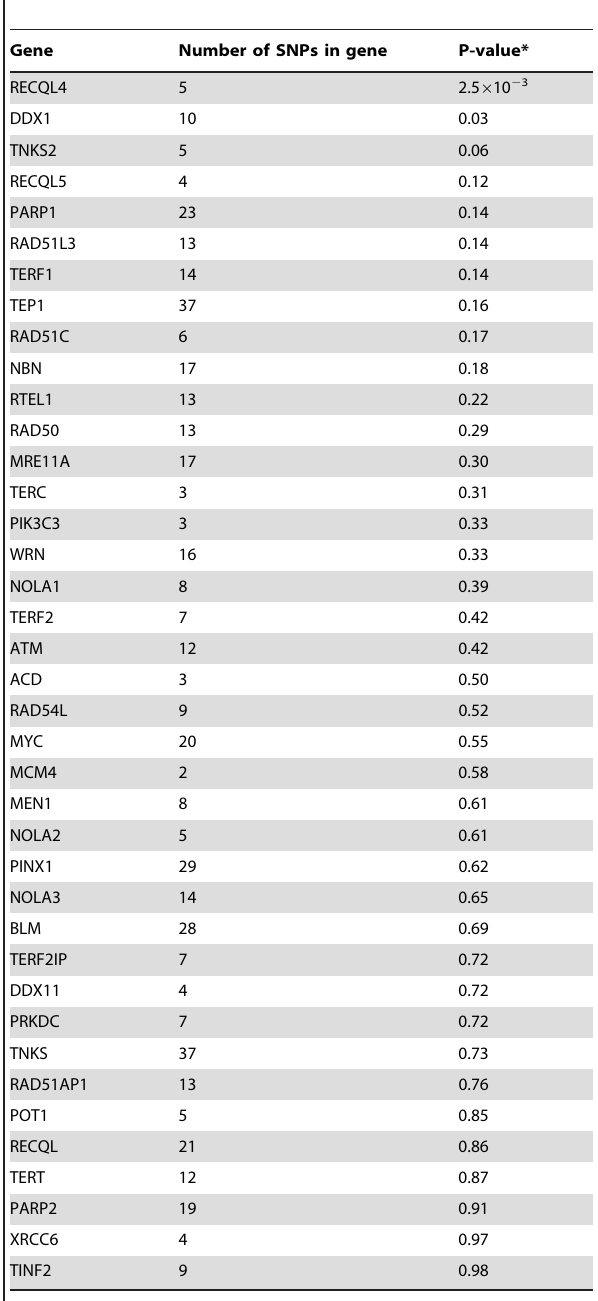
Table 2. Gene-based association analysis with the risk of